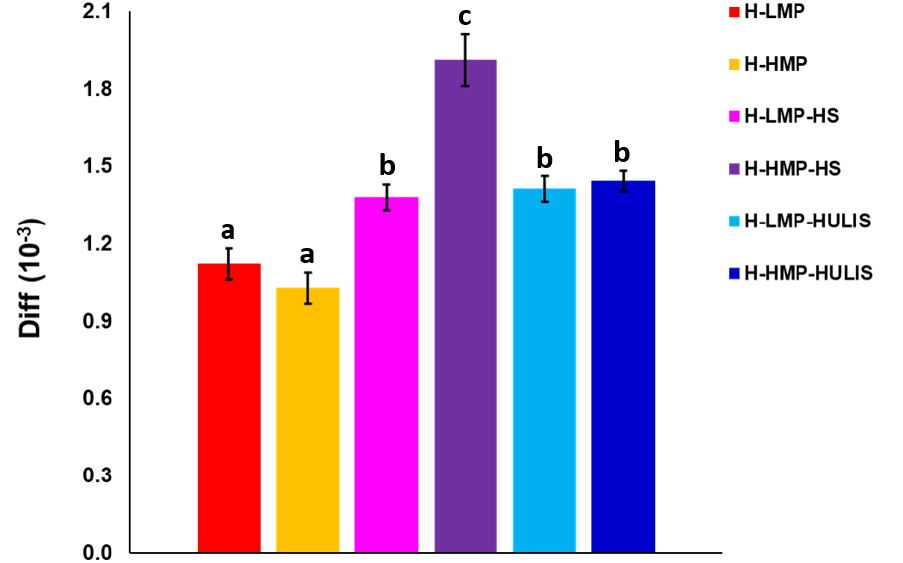
Figure 4. Diffusion coefficients (Diff) obtained from MRI experiments for the different hydrogels after the addition of 150 μL of water necessary to saturate samples. Error bars indicate standard error (n = 3), and different letters indicate significant differences by the Tukey’s test at p ≤ 0.05.